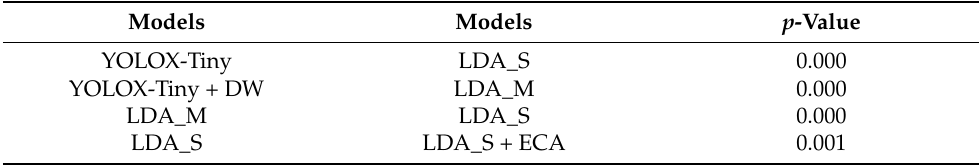
Table 7. One-way ANOVA with mAP for different improvement methods.